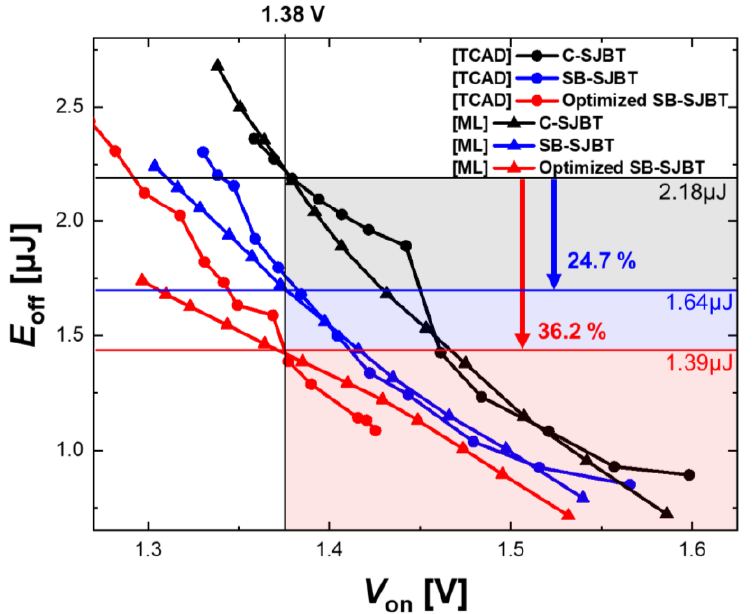
Figure 7. Comparing the trade-off graph extracted by the TCAD tool with the graph predicted by NN shows very high similarity. In addition, the optimal structure extracted by ML shows an improved trade-off.